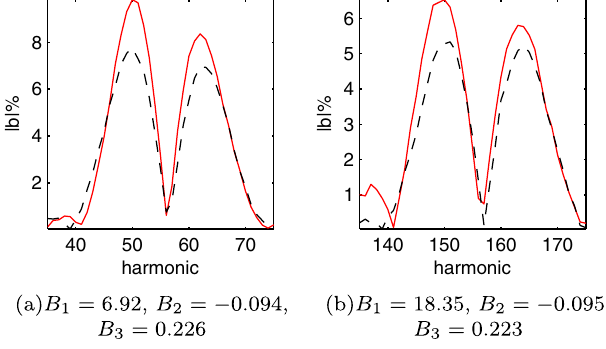
FIG. 10. I-EEHG compensation (red solid line) in third modulator for (a) 50th and (b) 150th harmonic. Standard EEHG is shown as a dashed line. Here A 1 ¼ A 0 1 ¼ 2 , A 2 ¼ A 0 2 ¼ 10 , A ¼ A 16 , (cid:3) ¼ 0 , (cid:3) ¼ (cid:1) , B ’ (cid:1) 1 =A ’ B 0 (cid:1) B 3 2 = 2 3 2 2 , B 3 2 2